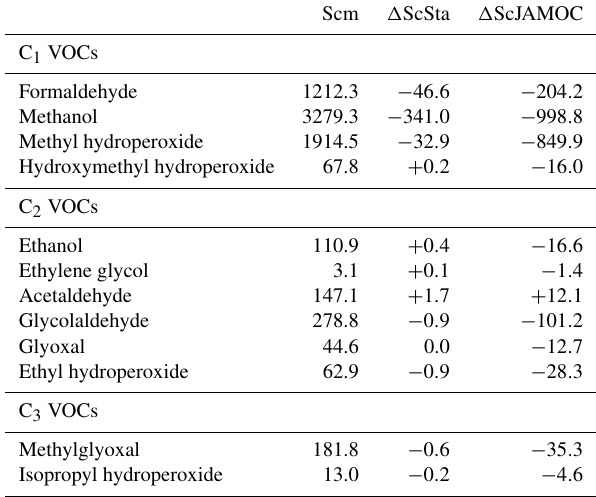
Table 2. Mean gas-phase tropospheric burden in 2015 for a selec- tion of VOCs for Scm and the changes induced by ScSta and Sc- JAMOC. The characteristics of each simulation are provided in Ta- ble 1. Burden values are given in gigagrams